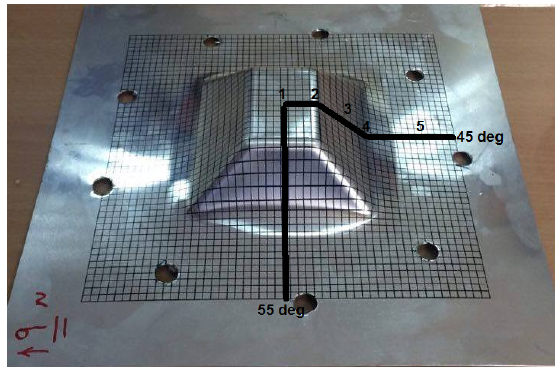
Fig. 11. Deformed sheet with identified